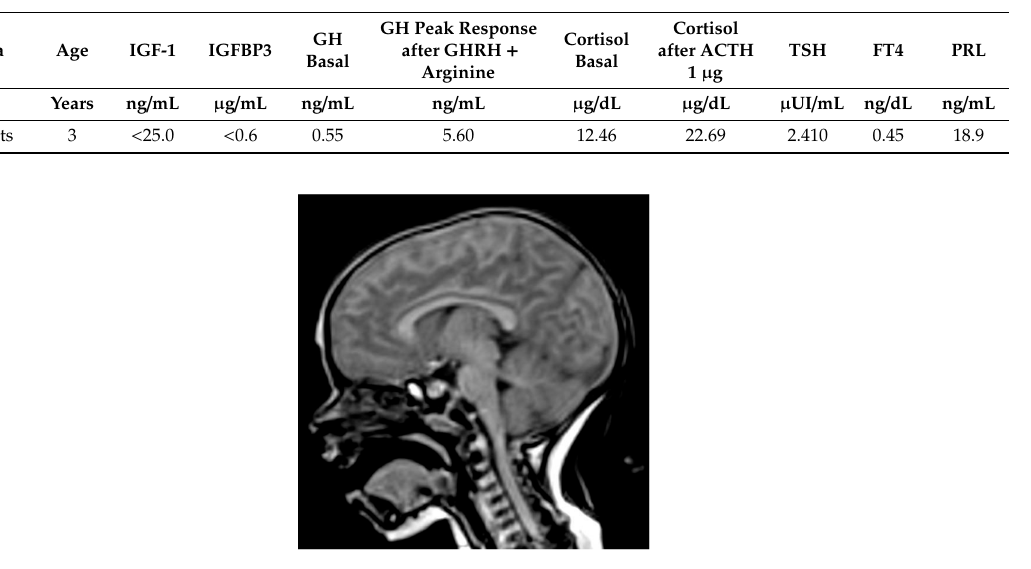
Figure 1. Sagittal pituitary MRI image showing hyper-intense enlarged anterior pituitary (T1-weighted sequence).